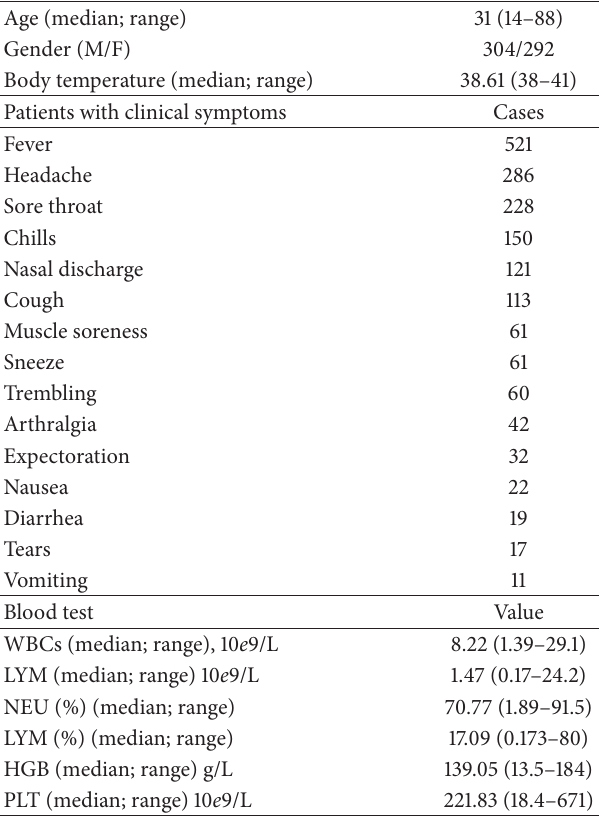
Table 1: Main clinical symptoms and blood test values of 596 patients